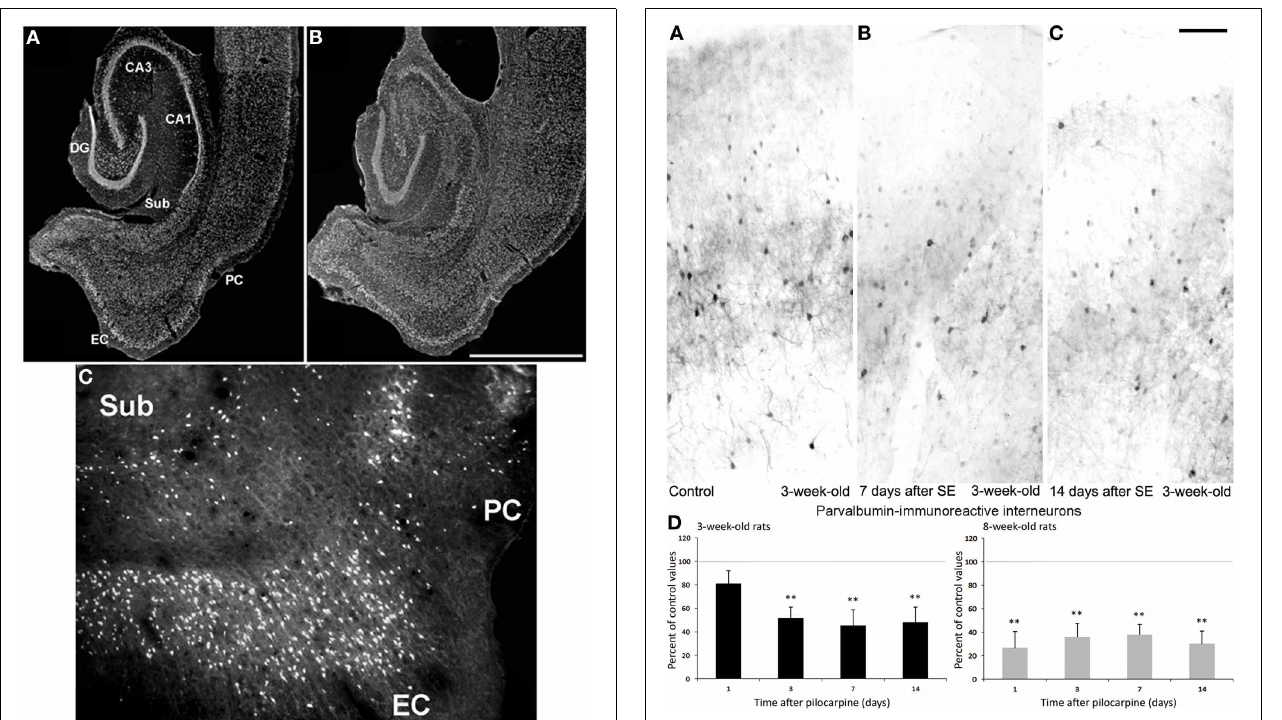
FIGURE 5 | Characterization of the neuronal damage occurring in the hippocampus and in parahippocampal structures in pilocarpine-treated rats. Rats were treated and processed as described in Biagini et al. (2005). (A and B) dark field photomicrographsof Nissl-stained brain sections obtained from a non-epileptic control rat and a pilocarpine-treated rat, respectively. Note that remarkable damage is localized to the Cornu Ammonis (CA) subfield 1 (CA1), hilus of the dentate gyrus (DG), layer III of medial entorhinal cortex (EC), whereas the subiculum (Sub) and perirhinal cortex (PC) are apparently spared. (C) Section stained by Fluoro-Jade to identify dying cells shows the presence of necrotic neurons also in the perirhinal cortex, but to a lower extent than in the entorhinal cortex. Scale bars, 1,900 μ m for (A) and (B) , 200 μ m for (C) .